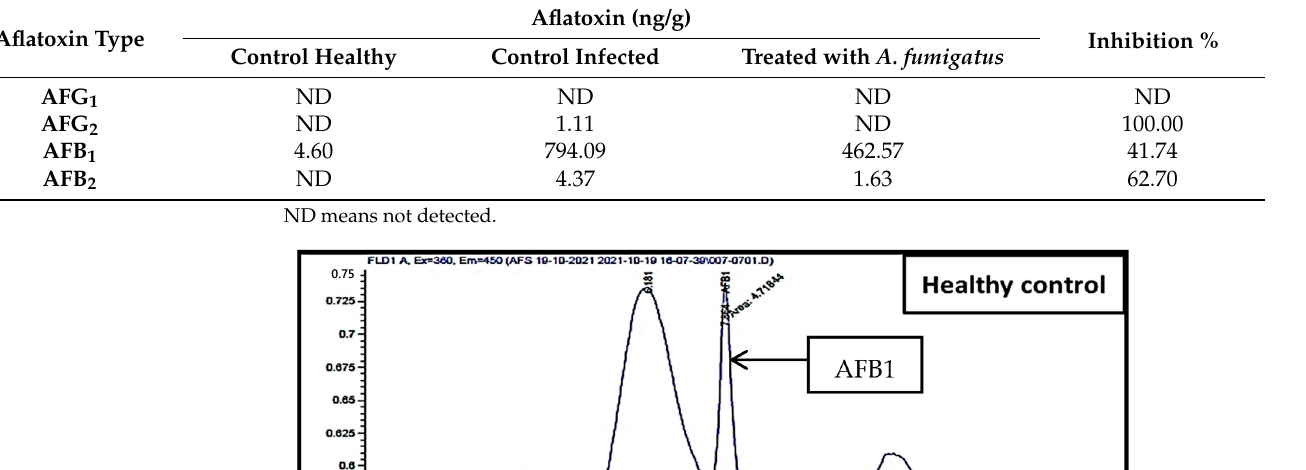
Table 2. Inhibition percentages of aflatoxins using A. fumigatus in vivo.